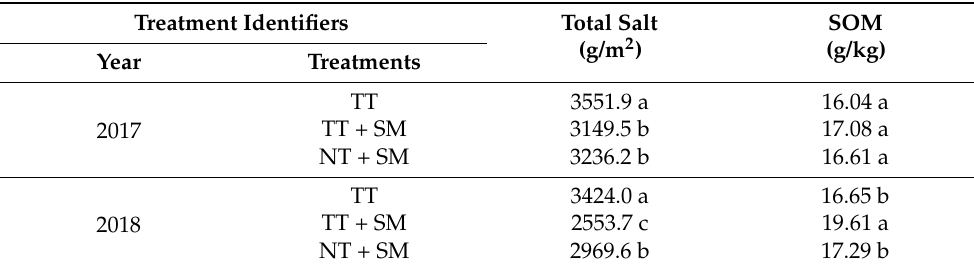
Table 3. Total salt and mean soil organic matter (SOM) in the top 30 cm soil layer at the end of the fallow period, i.e., early June of 2017 and 2018 before maize sowing, for the TT, TT + SM, and NT + SM treatments. TT: traditional tillage for maize cultivation without straw return after maize harvest; TT + SM: traditional tillage with 100% straw mulching after harvest; NT + SM: no-till cultivation combined with 100% straw mulching. Means in the same year followed by a different letter are significantly different ( p = 0.05).